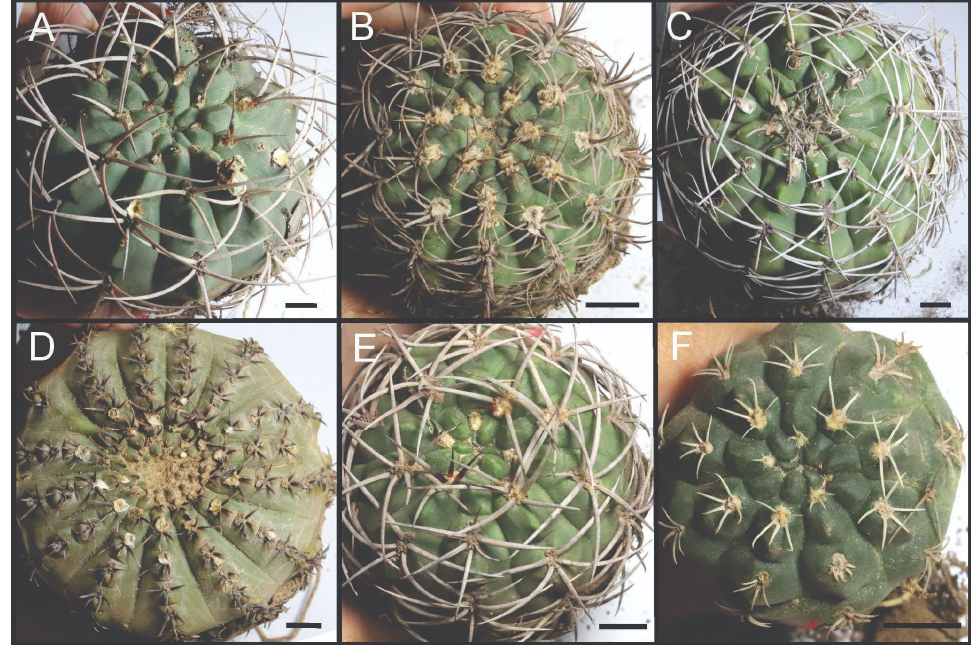
Figure 2. Top view of individuals of Gymnocalycium species. ( A ): G. pugionacanthum and ( B ): G. marianae , both from the arid site. ( C ): G. hybopleurum and ( D ): G. stellatum , both from the semiarid site. ( E ): G. oenanthenum and ( F ): G. baldianum , both from the subhumid site. Scale: 1 cm. Table 1. Summary of all measured variables with mean and standard deviation (SD) for each spe- cies. * Significant differences ( p ≤ 0.05). Means with the same letter are not significantly different. Arid Semiarid Subhumid